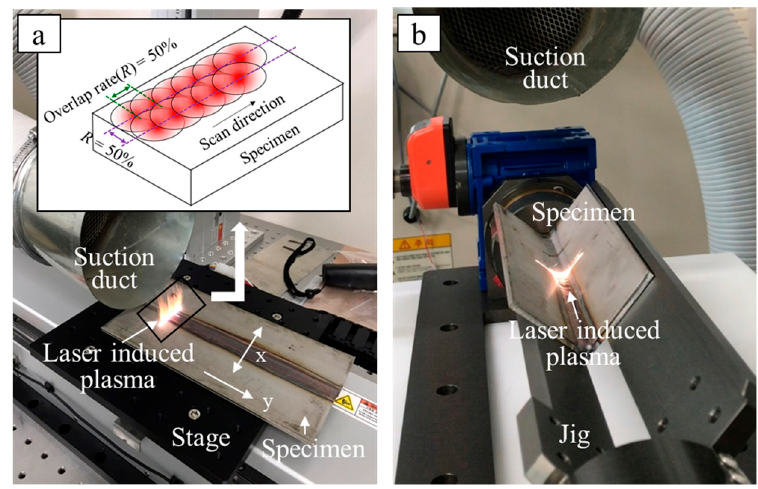
Figure 2. Laser cleaning experimental method according to the shape of the weld; ( a ) Butt weld, ( b ) Fillet weld.